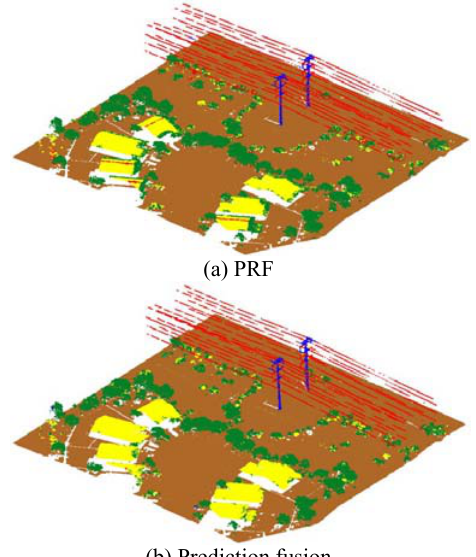
Figure 6. Classification map of TE#2 (green: vegetation, red: wire, blue: pylon, and yellow: